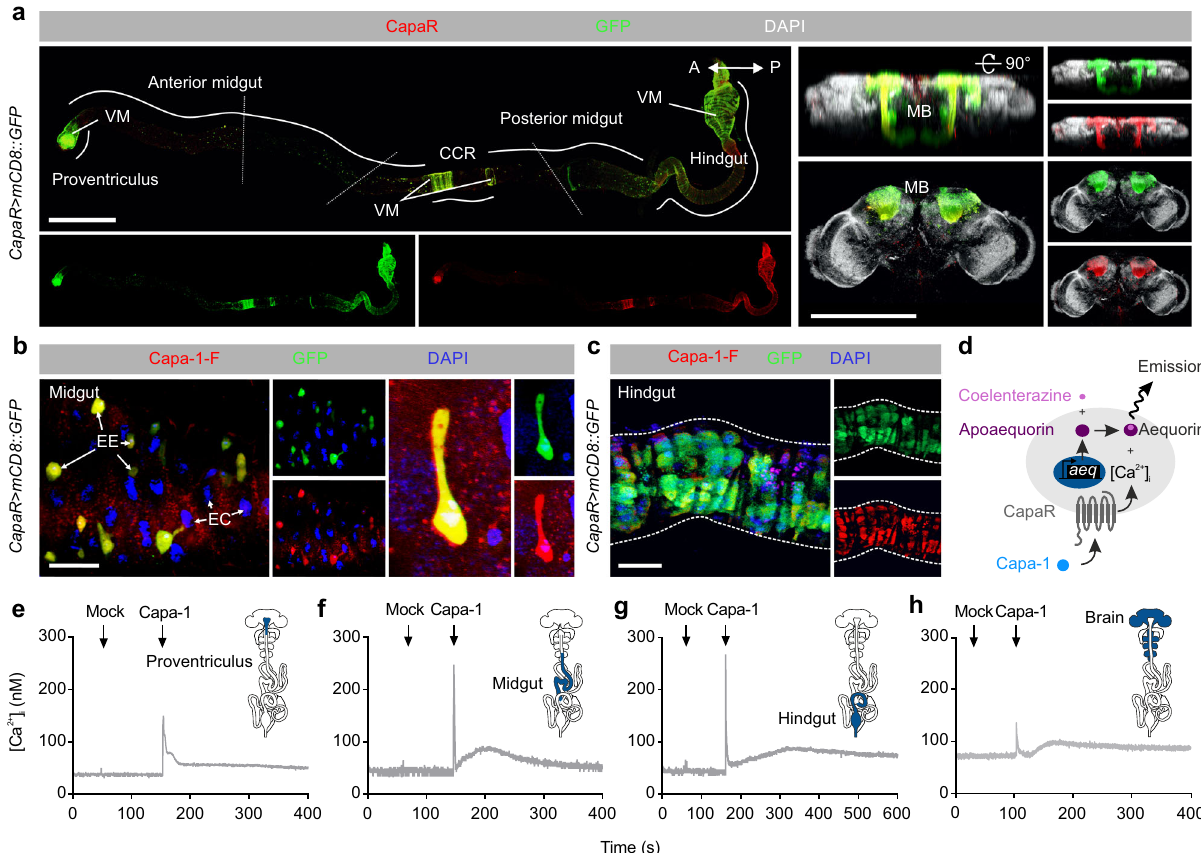
Fig. 2 Global mapping of CapaR expression. a Co-immunolabeling of the CNS and the intestine from CapaR > mCD8::GFP fl ies with a custom generated CapaR antibody consistently showed an overlap between GFP (green) and CapaR (red) immunoreactivity in the mushroom body (MB) and neuronal somata of the CNS, as well as in the visceral muscles (VM) and enteroendocrine cells (EEs) restricted to distinct portions of the gut. Image was acquired using “ Tile scan ” in the ZEN software (Zeiss, Oberkochen, DE) with boundaries between tiles marked by dashed line. EC, enterocytes; CCR, copper-cell region. Scale bars = 200 µ m. b – c Application of fl uorophore-labeled Capa-1 (Capa-1-F, red) on the intestine shows speci fi c and displaceable binding to CapaR > GFP (green) positive enteroendocrine cells (scale bar = 20 µ m) and visceral muscles (scale bar = 40 µ m). d Principle of in vivo aequorin luminescence-based functional calcium assay in Drosophila tissues. e – h Real-time changes in intracellular Ca 2 + concentration of tissues acutely dissected from fl ies expressing a UAS-apoaequorin transgene ( CapaR > aeq::GFP ). Cytosolic [Ca 2 + ] i levels (nM) in e proventriculus, f midgut, g hindgut and h brain upon Capa-1 stimulation (10 − 7